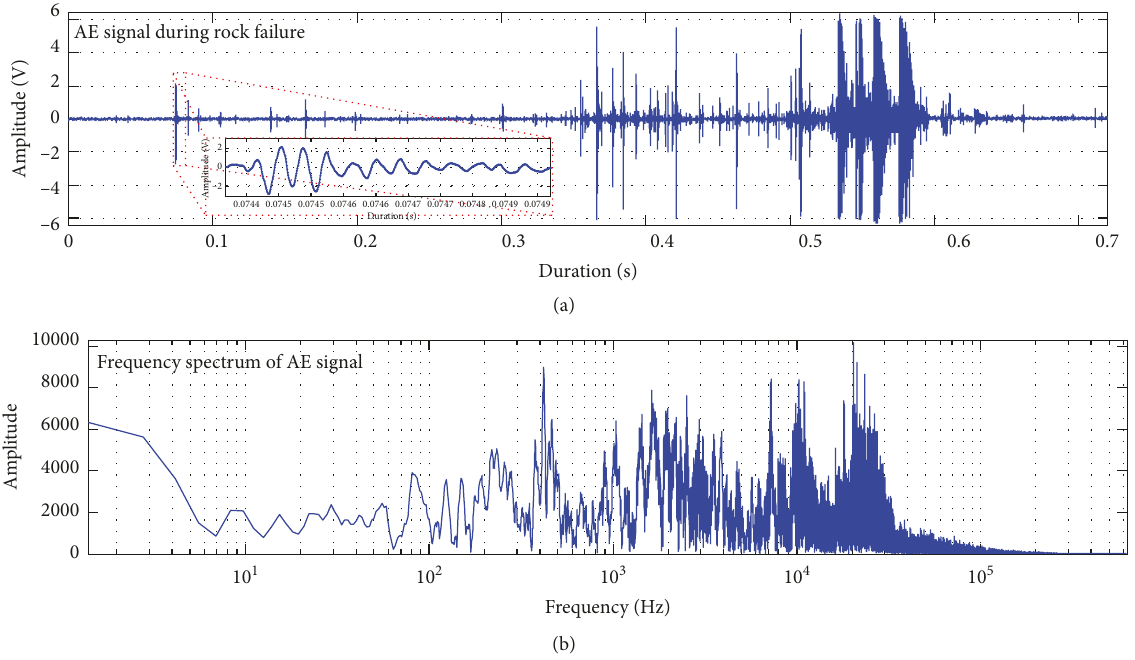
Figure 2: The AE signal and frequency spectrum of 1# red sandstone specimen at the complete fracturing moment. (a) Time-varying AE signal; (b) signal frequency spectrum.